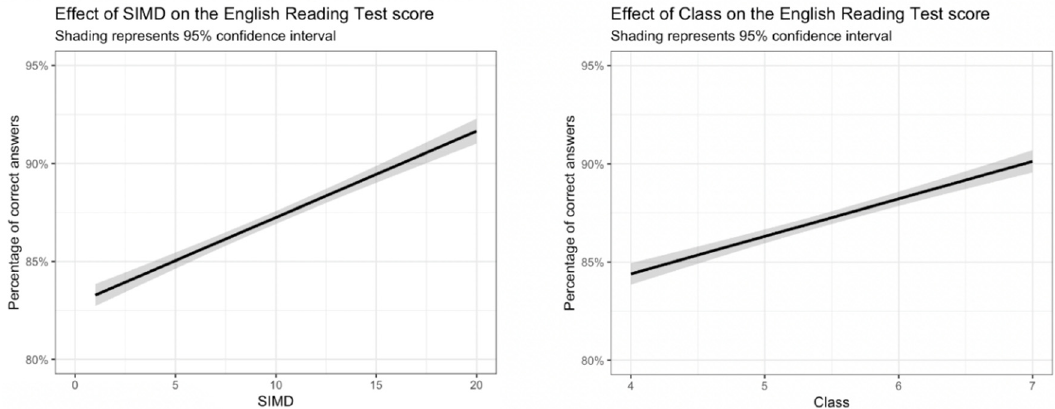
Figure 6. Effects of Scottish Index of Multiple Deprivation (SIMD) and class on total score of the English Reading for All.